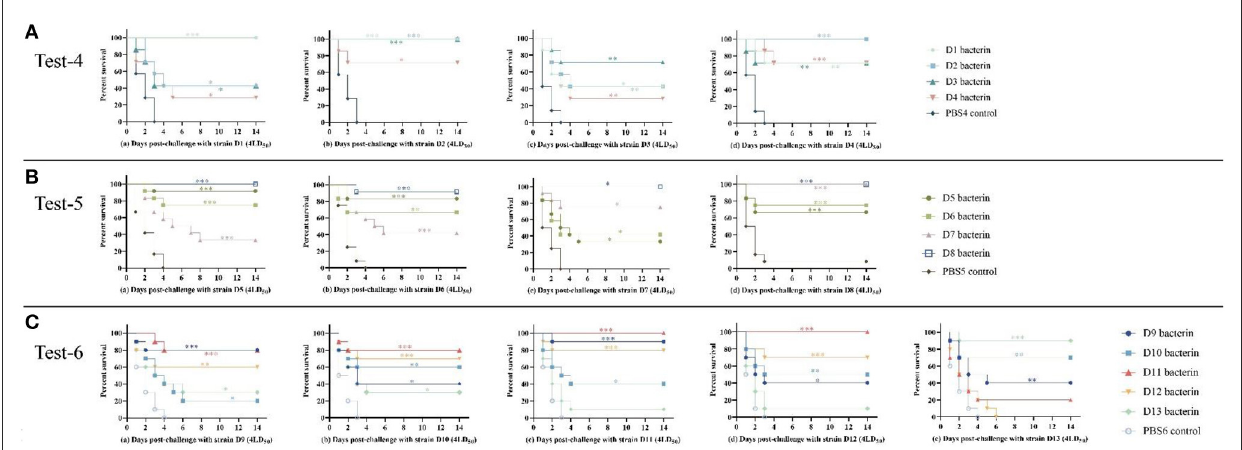
FIGURE4 Survival-time curves of mice immunized with the D1–D13 bacterins when challenged with serogroup D P. multocida strains (Test-1–3). (A) Test-4, mice were subcutaneously immunized with the D1–D4 bacterins, and intraperitoneally challenged with (a–d) 4LD 50 of strain D1, D2, D3, or D4. (B) Test-5, mice immunized with the D5–D8 bacterins were intraperitoneally challenged with (a–d) 4LD 50 of strain D5, D6, D7, or D8. (C) Test-6, mice immunized with the D9–D13 bacterins were intraperitoneally challenged with (a–e) 4LD 50 of strain D9, D10, D11, D12, or D13. Each group